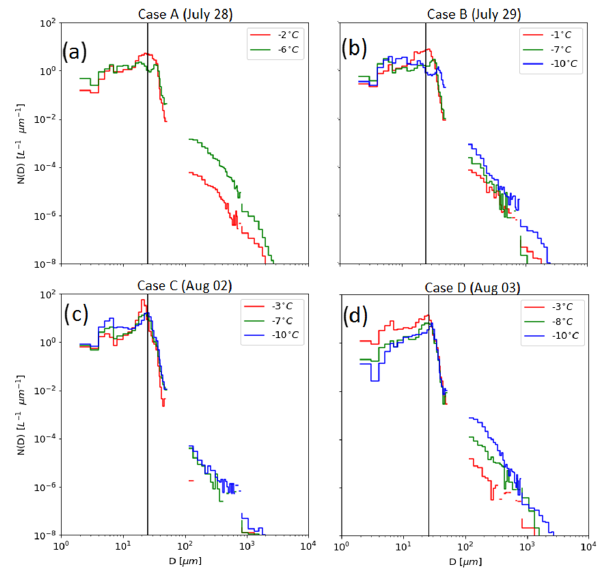
Figure 5. Mean N(D) from the CDP, CIP, and 2DP for the spec- ified penetrations from (a) Case A, (b) Case B, (c) Case C, and (d) Case D. The solid black line denotes